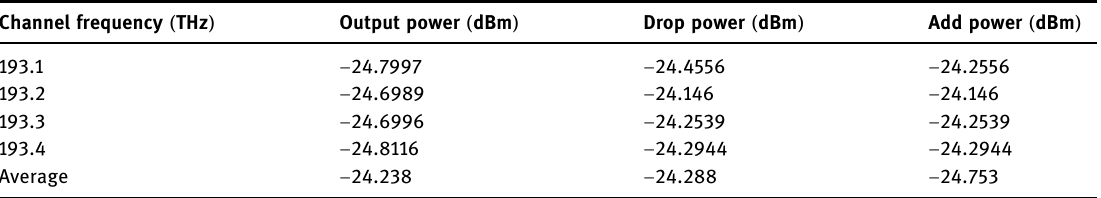
Table 3: The output power for add, drop, and output calculated by the electrical power meter analyzer Channel frequency ( THz